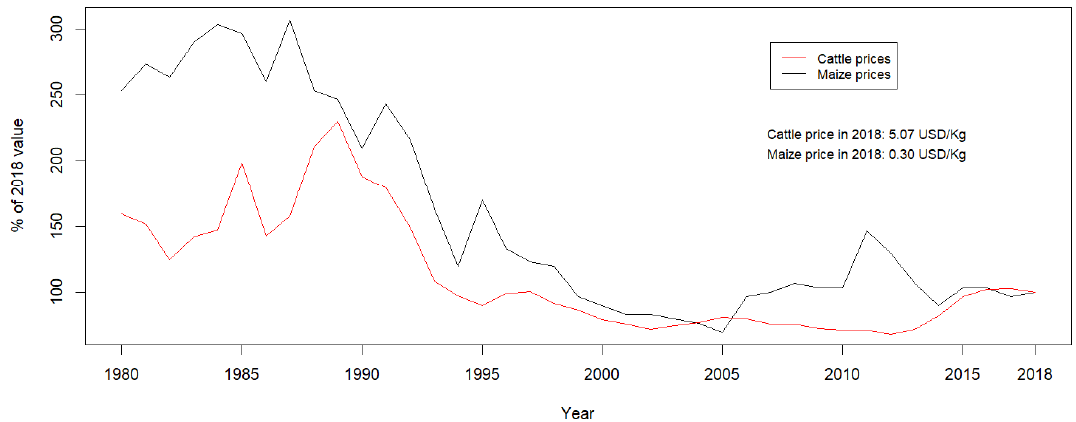
Figure 3. Cattle and Maize Prices payed to farmers in Michoacán (in 2018 US$).